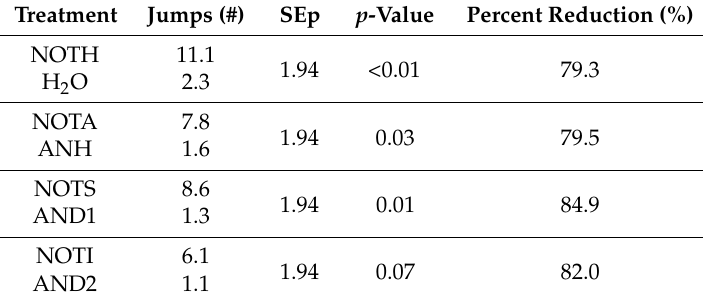
Table 4. Comparison of average number of jumps for dogs receiving no correction (NOTH) vs. water-only spray (H 2 O), no correction (NOTA) vs. androstenone + water spray (ANH), no correction (NOTS) vs. androstenone 0.1 µ g/mL (AND1), or no correction (NOTI) vs. androstenone 1.0 µ g/mL (AND2) in response to each instance of jumping up. n = 10 dogs/treatment. Treatment Jumps